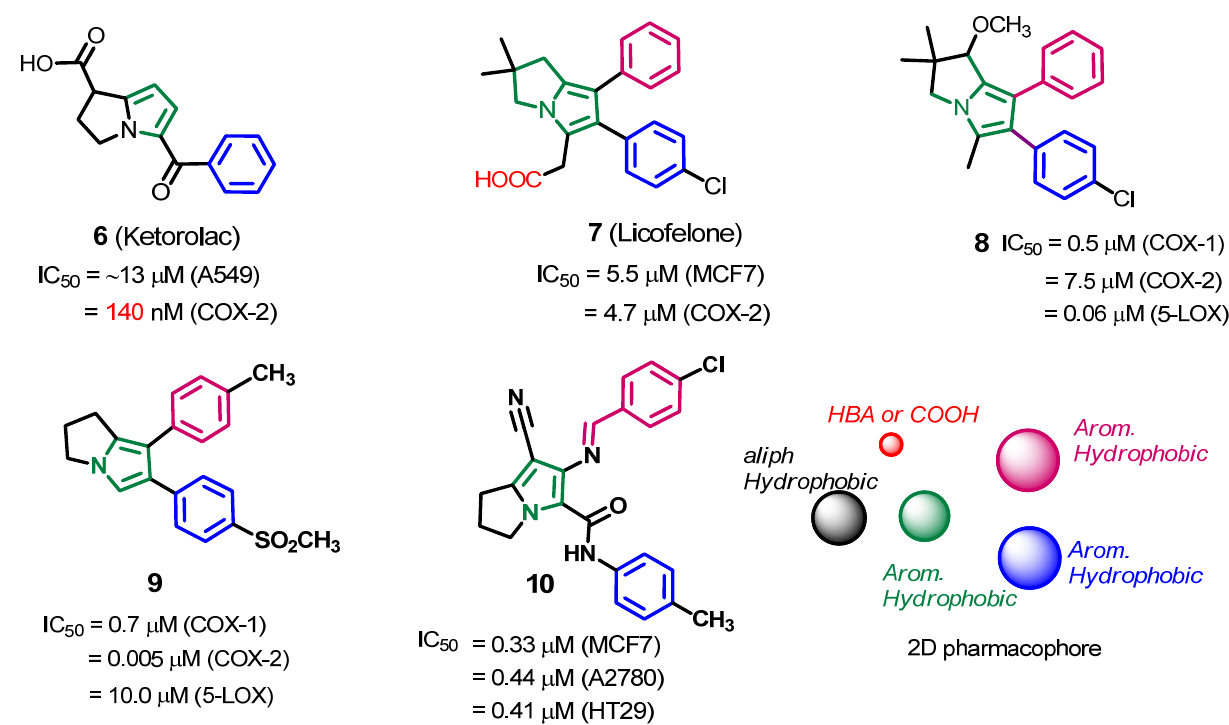
Figure 2. Pyrrolizines 6 – 10 with anti-inflammatory and/or anticancer activities and a 2D pharmacophore generated based on their chemical structures.